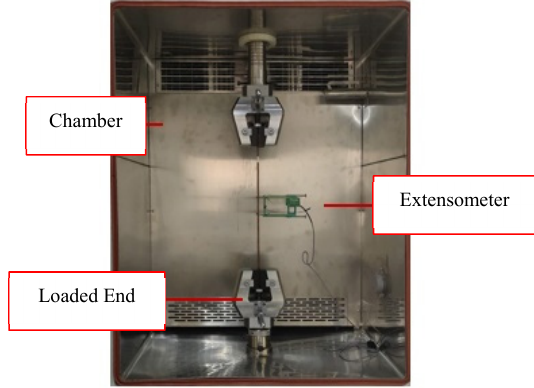
Figure 3. Tensile loading set-up.